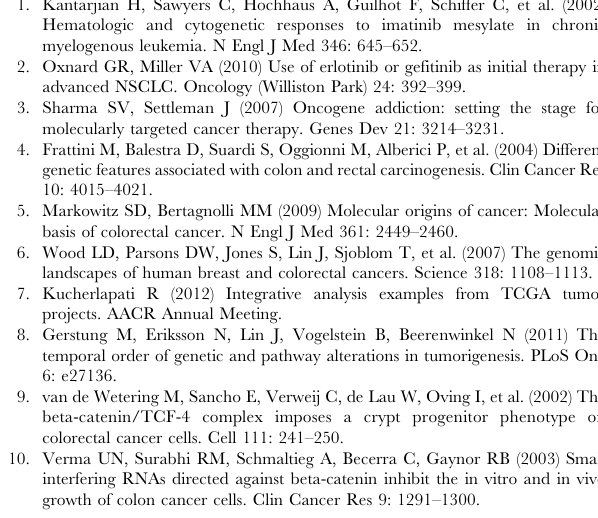
Figure S7 Western blot analysis of siRNA target genes. Ls174T cells stably expressing dox-inducible shRNAs were treated for 3 days with doxycycline. Total cell lysates were probed with anti- b -catenin (BCAT), anti-KRAS or anti-actin antibodies. siNT, non-targeting siRNA; siBC, anti- b -catenin siRNA; siKR, anti- KRAS siRNA. (TIF) Figure S8 CD44, Cyclin D1 and BCL2 expression fold change obtained in DLD-1, SW480 and HCT-116 cells. The cells were treated for 72 hours with the indicated compounds. Gene expression was analyzed by real-time PCR as in figure 4B. PYRV = pyrvinium. (TIF) Figure S9 Repeated oral administration of pyrvinium pamoate (10 mg/kg q.d. for 3 days) did not cause pygopus down-modulation in nude mice. Two control mice and two treated mice are shown. A marker lane running in the middle of the gel has been deleted. Actin is shown as a loading control. (TIF) Table S1 Mutations in the genes encoding APC, b - catenin, KRAS, BRAF and p53, and microsatellite instability status (MSI) of CRC cell lines used in this study. Table S2 Primers used for QPCR analysis. The com- mon protein name is provided in brackets along with the official gene symbol, when